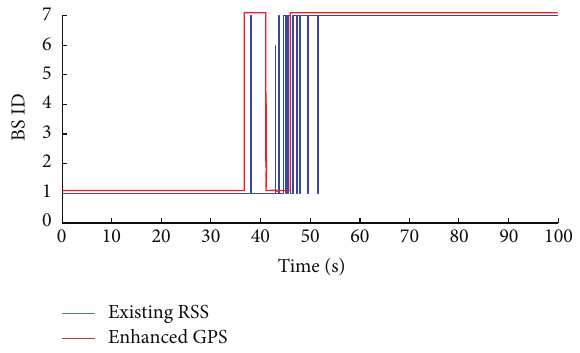
Figure 6: The simulation steps.